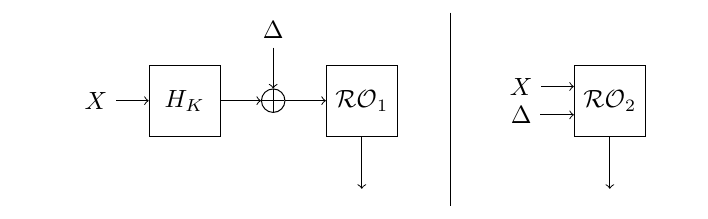
Figure 1: The distinguishability setup for bkh. Left is the real world O and right is the ideal world P